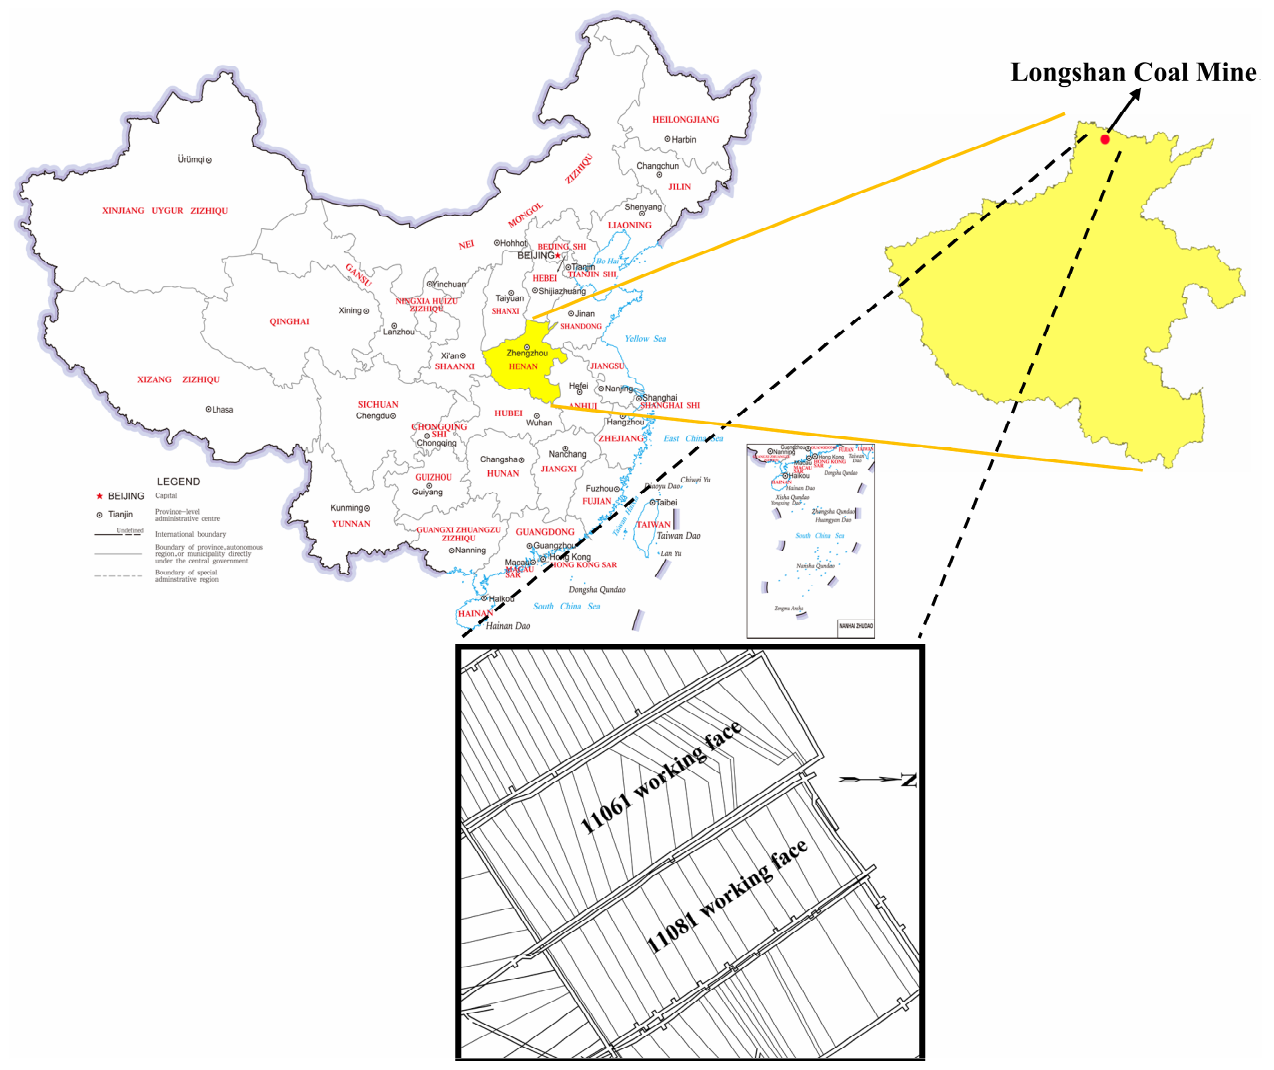
Figure 1. Schematic of the study area location.